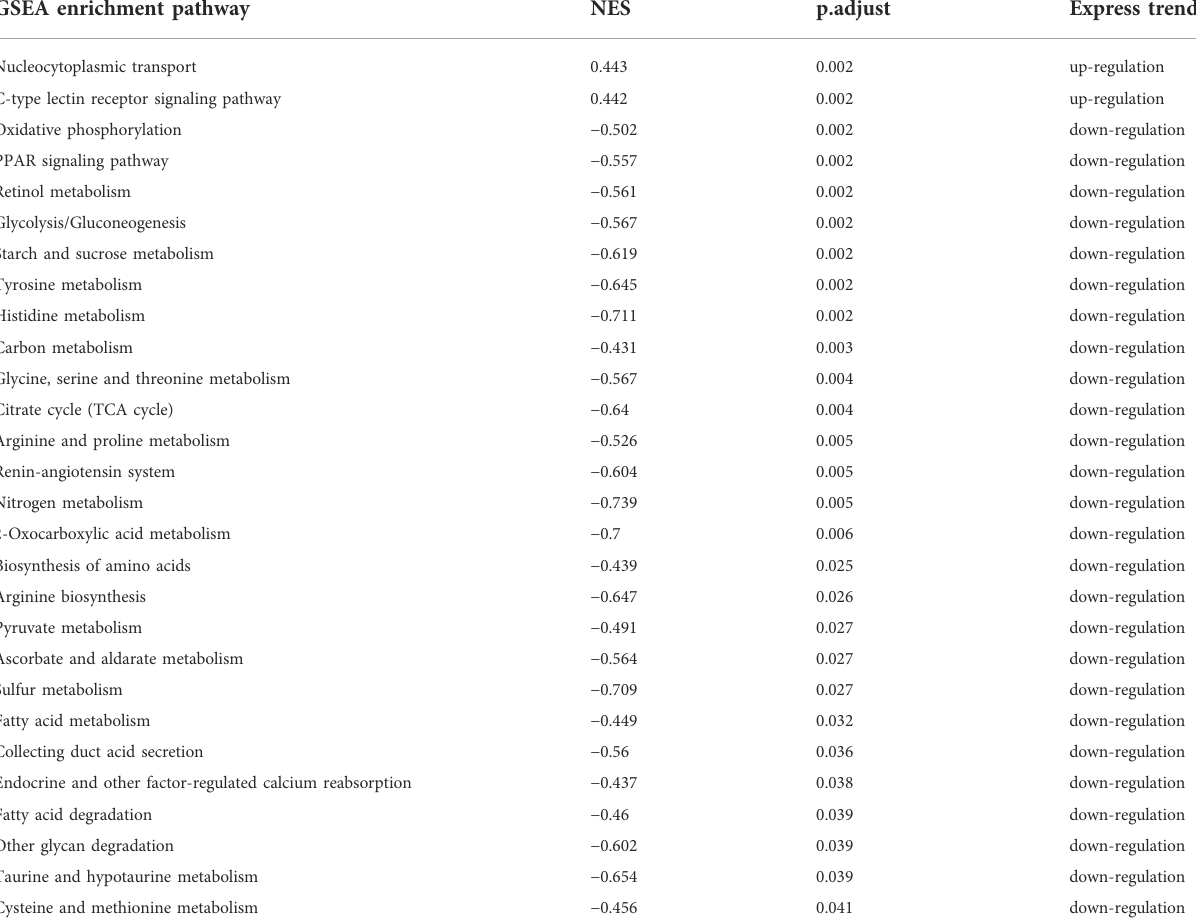
TABLE 3 The unique enrichment pathways in GSEA analysis of genes in 28min – 26min